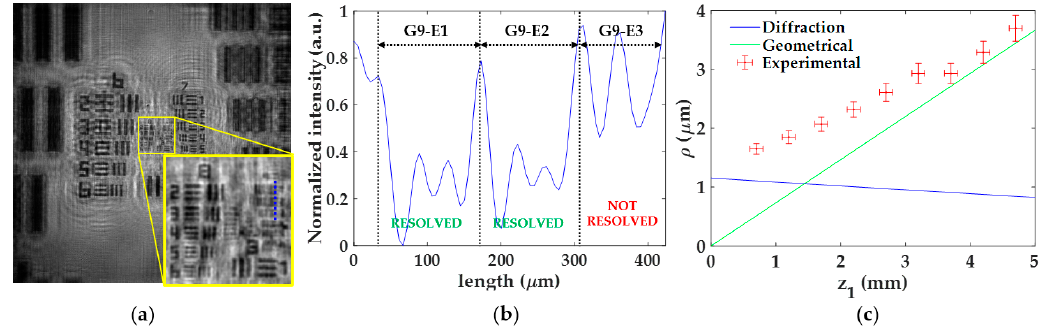
Figure 5. Experimental procedure for the analysis of the lateral resolution ρ . ( a ) Focused image for the distance z 1 = 0.7 ± 0.1 mm; ( b ) intensity profile along blue line included in ( a ) for resolution limit determination; ( c ) calibration curve of the lateral resolution considering both experimental values and theoretical resolution limits according to diffraction and geometrical constraints.